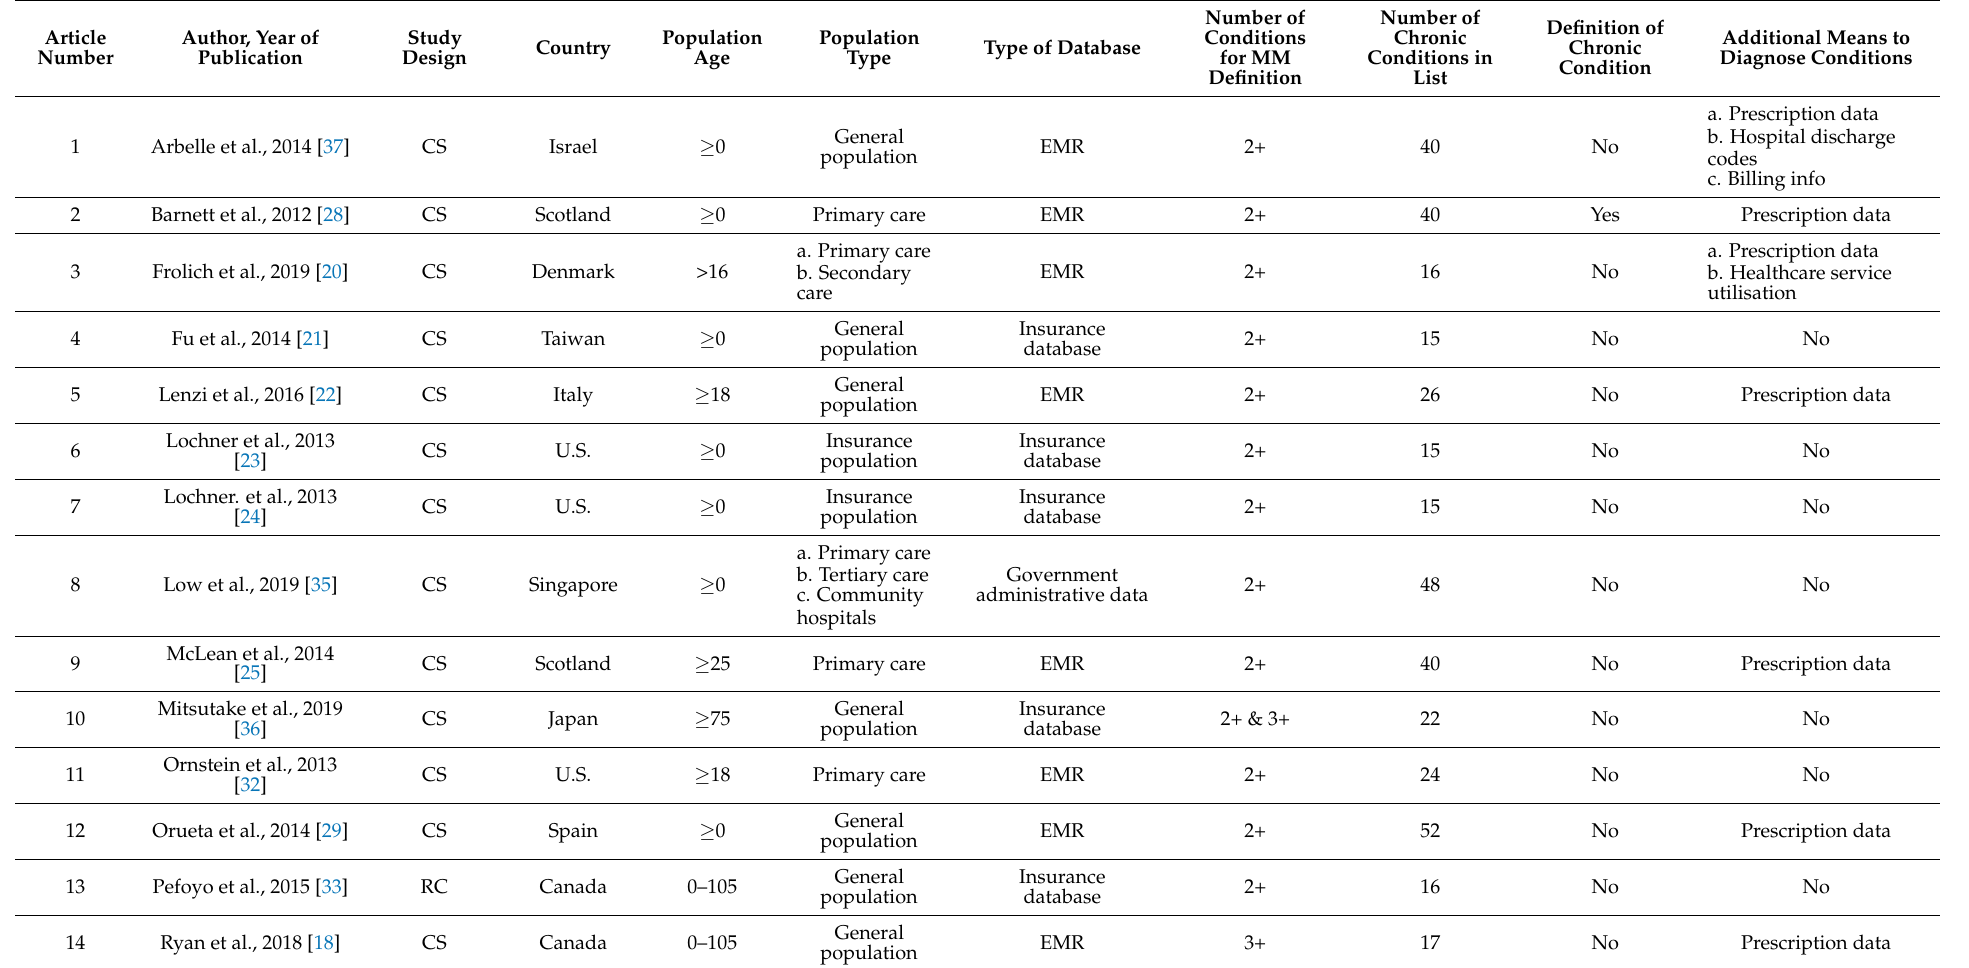
Table 1. A comparison of study characteristics and definitions of multimorbidity used in the 20